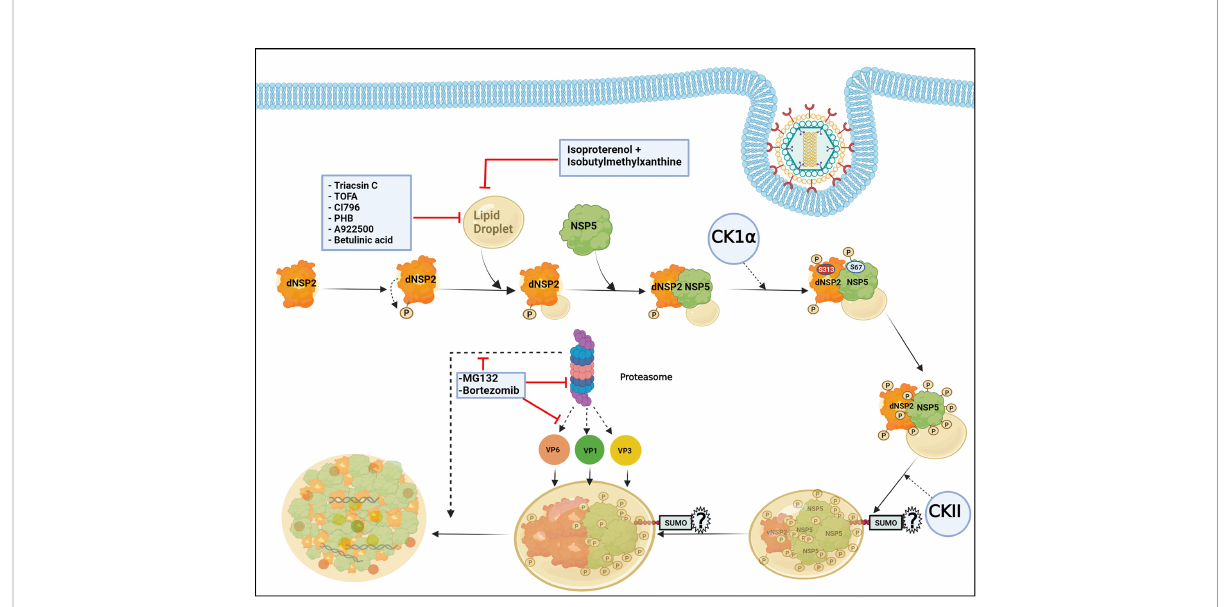
FIGURE 2 Host cellular contribution in regulating early viroplasm dynamics. Following entry to the host cell, RV NSP2, and NSP5 initiate viroplasm biogenesis. Nucleation of the viroplasm starts with the cytoplasmic, dispersed NSP2 (dNSP2) which phosphorylates itself by the intrinsic NTPase and autokinase activity. NSP2 further interacts with Lipid droplets (LDs) and hypophosphorylated NSP5. Host cellular protein CK1 a localizes to viroplasms and phosphorylates NSP2 (at serine 313) and NSP5 (at serine 67). NSP5 is also phosphorylated by another host cellular kinase CKII and by the kinase activity of NSP2. Gradually, NSP5 becomes hyperphosphorylated and dNSP2 gets converted into viroplasmic NSP2 (vNSP2) through conformational changes. The size of the viroplasms and LDs continues to increase over time and the maturing viroplasms accumulate other viral proteins such as VP1, VP2, and VP6. An active ubiquitin proteasome system (UPS) is required for the early dynamics of viroplasms. Proteasome inhibition by small molecules (by MG132 and Bortezomib) leads to smaller viroplasmic size and abrogated translocation of VP1, VP2, and VP6 into the viroplasms. Inhibiting LD biogenesis by targeting the enzymes of the LD synthesis pathway or promoting LD fragmentation compromises early viroplasm dynamics. Notably, SUMOylation of NSP5 at multiple lysine residues has been shown to be important for NSP5- VP2 induced viroplasm-like structure (VLS) formation. However, the importance of NSP5 SUMOylation in viroplasm formation under natural infection scenarios is